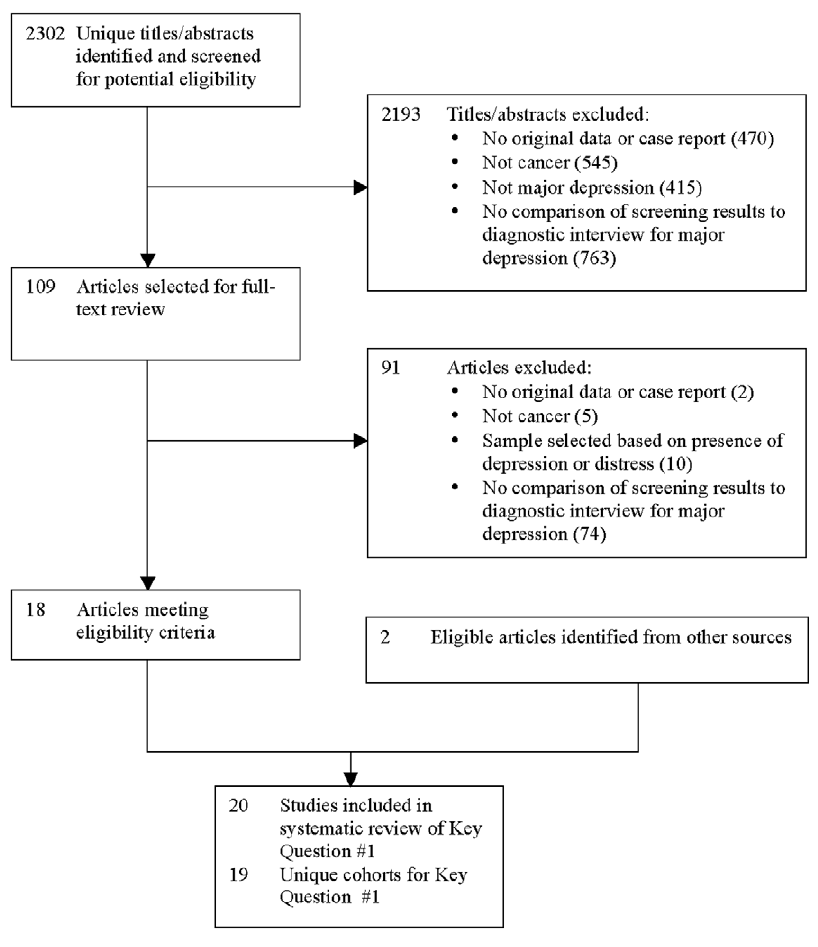
Figure 2. PRISMA Flow Diagram of Study Selection Process for Key Question # 1.